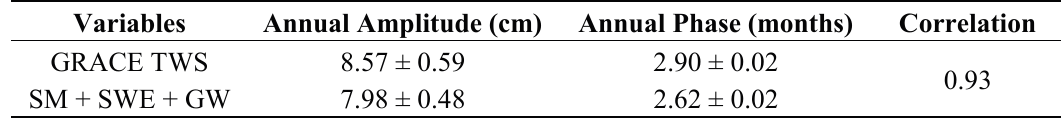
Table 1. Annual amplitude and phase of terrestrial water storage (TWS) from GRACE (average of 3 institutions) and simulations (average of 3 GLDAS models) with confidence level of 95%. The significance level of the correlation coefficient is